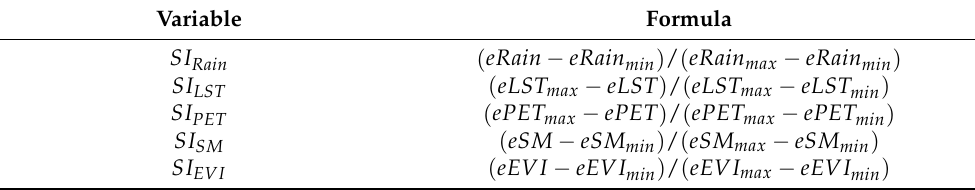
Table 3. Formulas of the severity index